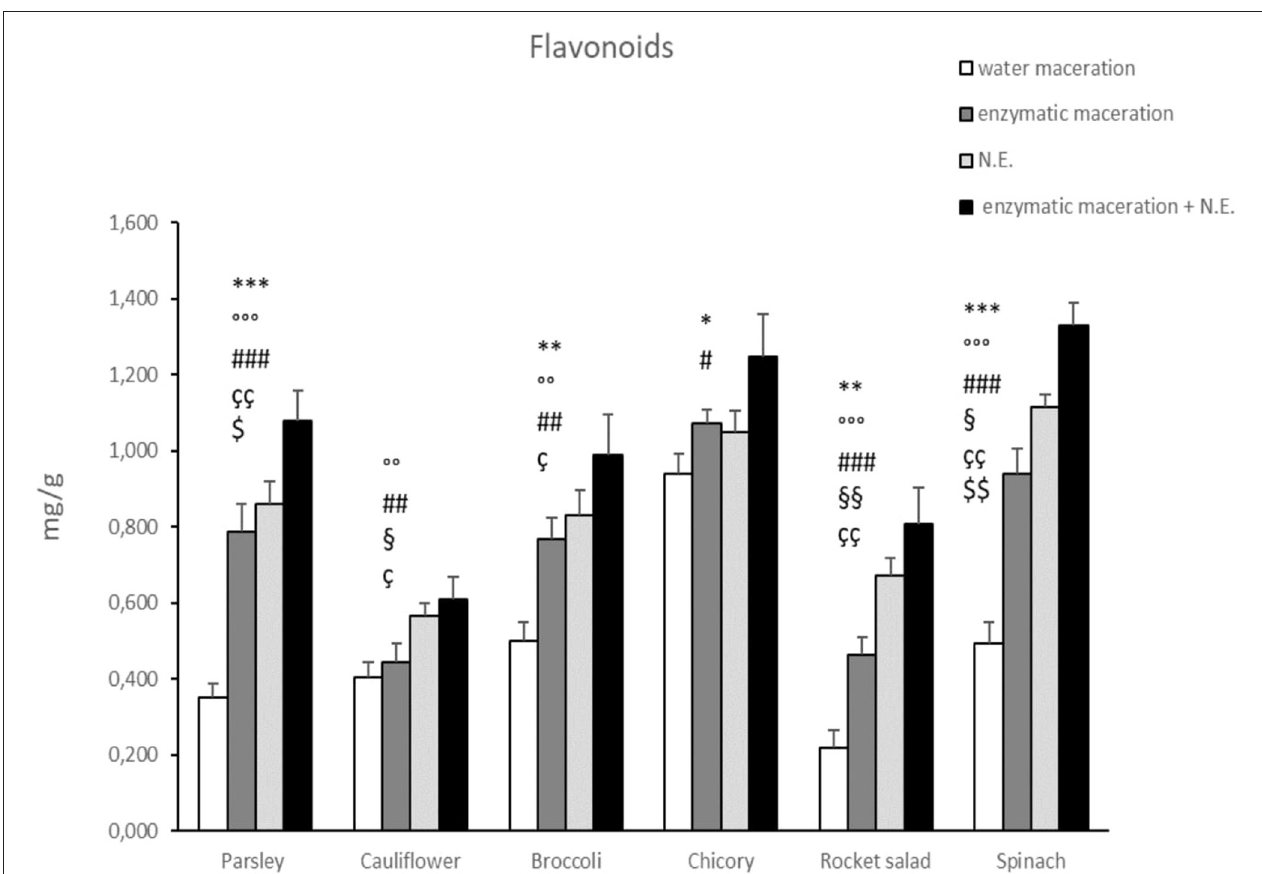
FIGURE 2 | Flavonoids content (mg/g) in the different extracts obtained from vegetable waste. Data are expressed as mean values ± standard deviation. Statistical analysis: within-group comparison (Flavonoids at different extraction methods) carried out by repeated measures analysis of variance. Level of significance: p < 0.05 expressed with comparison symbols: (*) water maceration vs. enzymatic maceration, ( ◦ ) water maceration vs. N.E., (#) water maceration vs. enzymatic maceration + N.E., (§) enzymatic maceration vs. N.E., (ç) enzymatic maceration vs. enzymatic maceration + N.E., ($) N.E. vs. enzymatic maceration + N.E. N.E., Naviglio Estrattore®. Statistical analysis: Continuous variables were reported as mean values ± standard deviation (SD), and were analyzed using nonparametric tests (i.e., Friedman and Wilcoxon test, as appropriate), since these variables were not normally distributed (based on the Shapiro-Wilk statistic). All tests were two-sided and a p < 0.05 was considered as statistically